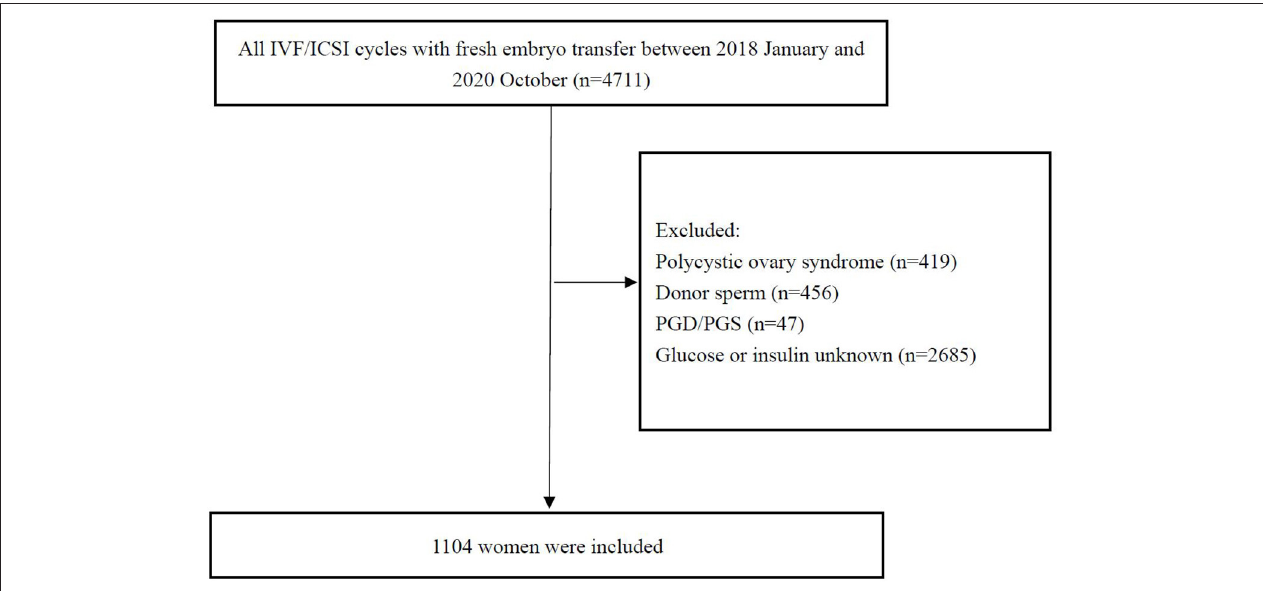
FIGURE 1 | Flowchart for selecting women included in this